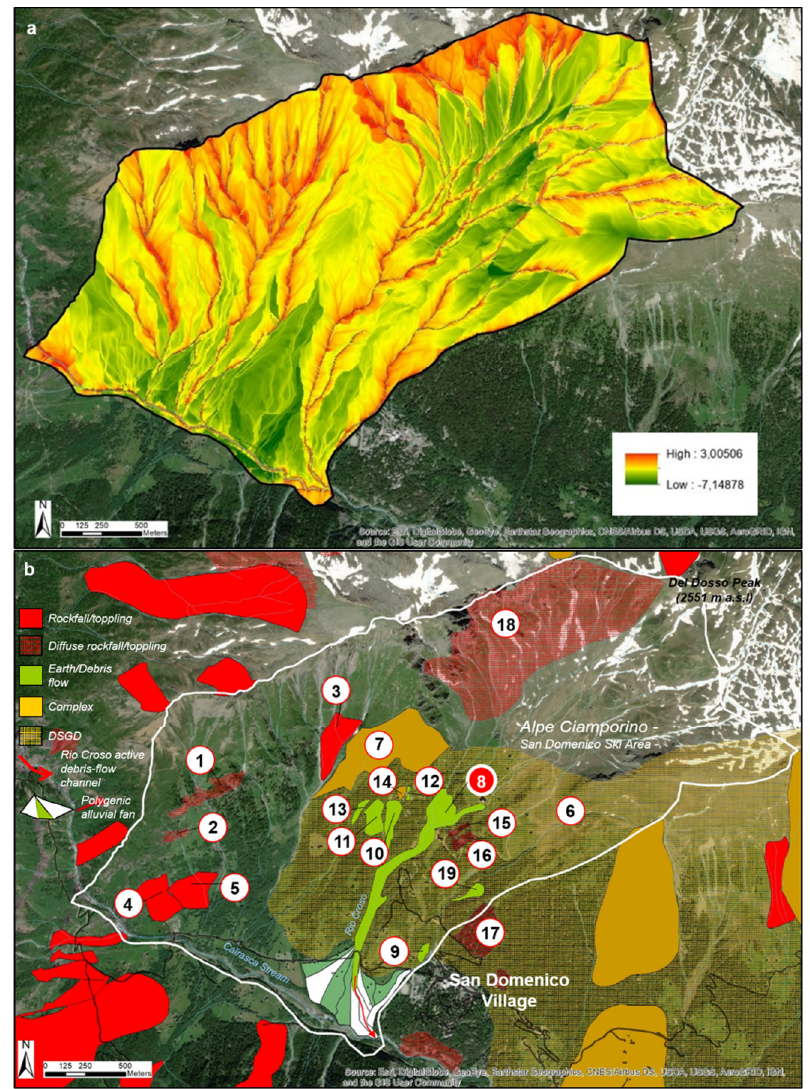
Figure 5. Sediment connectivity and hydrogeological instabilities within the Croso stream basin. ( a ) the Index of Connectivity map with channel network as target elaborated according to [40] using the DTM 5 m resolution; ( b ) the alluvial fan (source http://webgis.arpa.piemonte.it/geoportale/) and landslides retrieved from the WMS of the IFFI–Italian Landslides inventory (source ttp://www.progettoiffi.isprambiente.it/cartografia-on-line/ recently moved to https: // idrogeo.isprambiente.it / app /